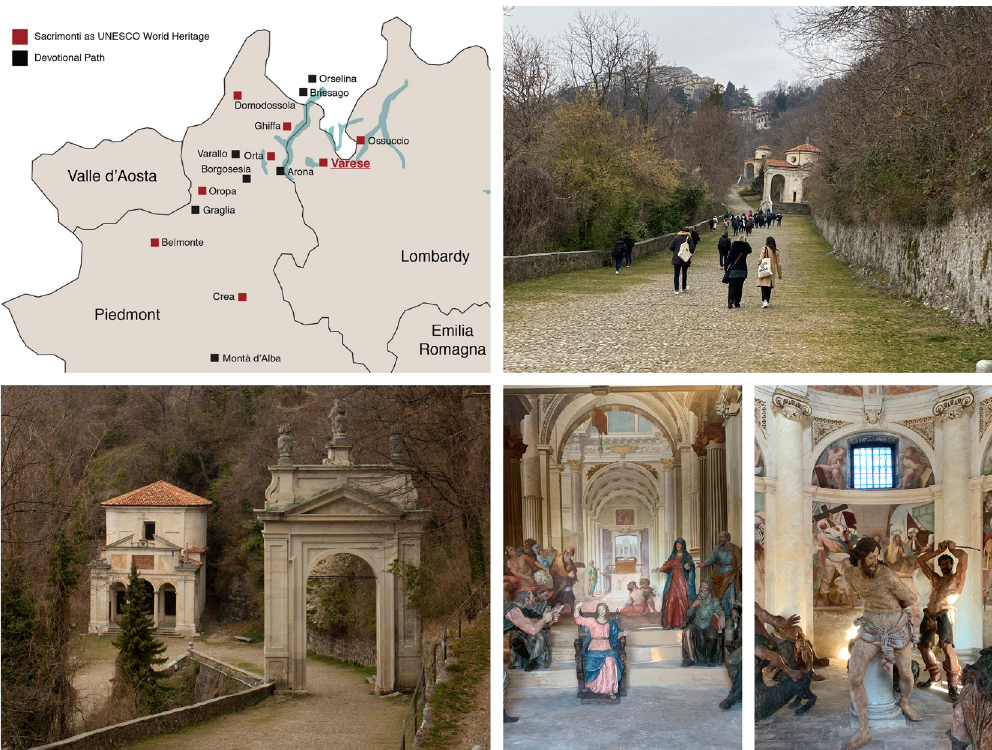
Fig. 1 In the spirit of the Counter Reformation, the architectural complex of Sacro Monte represents an entirely iconological communicative model of catechetical